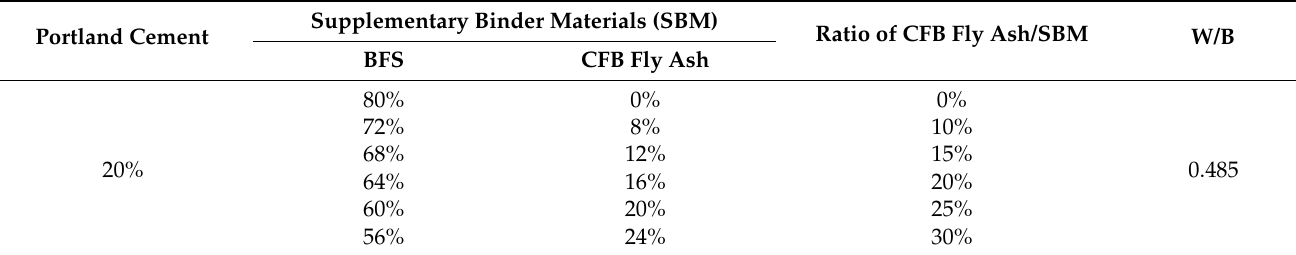
Table 2. Proportions of CFB fly ash-BFS blended mortar.